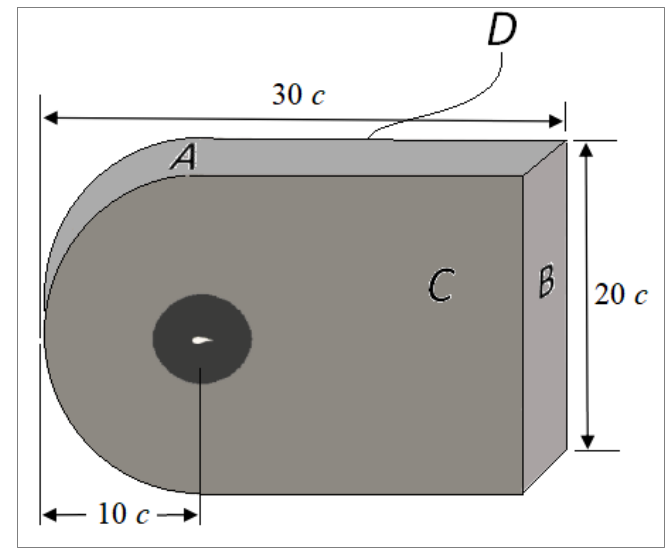
Figure 4. Computational domain used for numerical